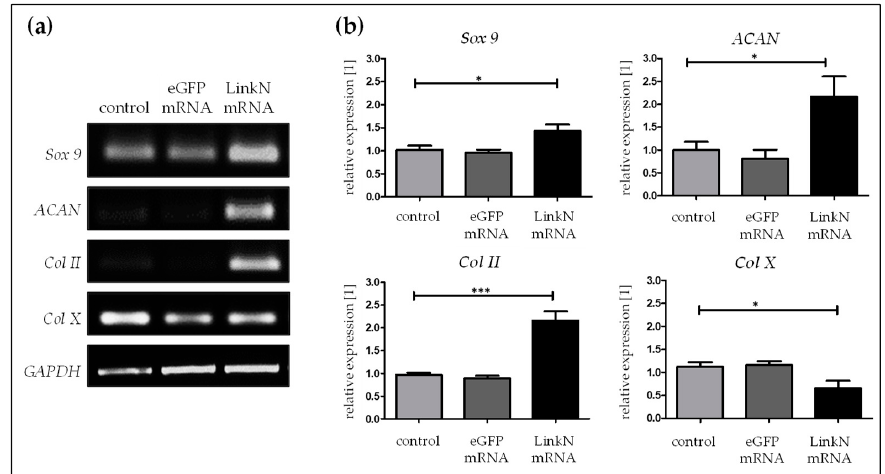
Figure 5. Influence of Link N mRNA delivery into SCP1 cells on aggrecan ( ACAN ), Sox 9 , type II and type X collagen gene expression.SCP1 cells (1 × 10 5 ) were transfected with 1 µg of Link N mRNA, and the influence on the expression of chondrocyte-specific markers was investigated. ( a ) Representative gel images evaluating the changes in ACAN , Sox 9 , Col II and Col X gene expression, 24 h after Link N mRNA transfection. ( b ) Changes in ACAN , Sox 9 , Col II and Col X gene expression were examined 24 h after Link N mRNA transfection, using semi-quantitative RT-PCR. Cells treated with Lipofectamine 2000 and eGFP mRNA transfected cells were used as controls. GAPDH was used as an internal control and served to normalize the expression. Relative expression levels obtained by densitometric analyses are represented as mean ± SEM (N = 3) and were compared using one-way ANOVA with Bonferroni’s multiple comparison test (*** p < 0.001, * p < 0.05).